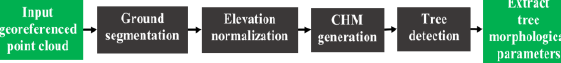
Ground points were eliminated from the georeferenced point cloud and elevation was normalized for the non-ground points at the preprocessing steps (Figure